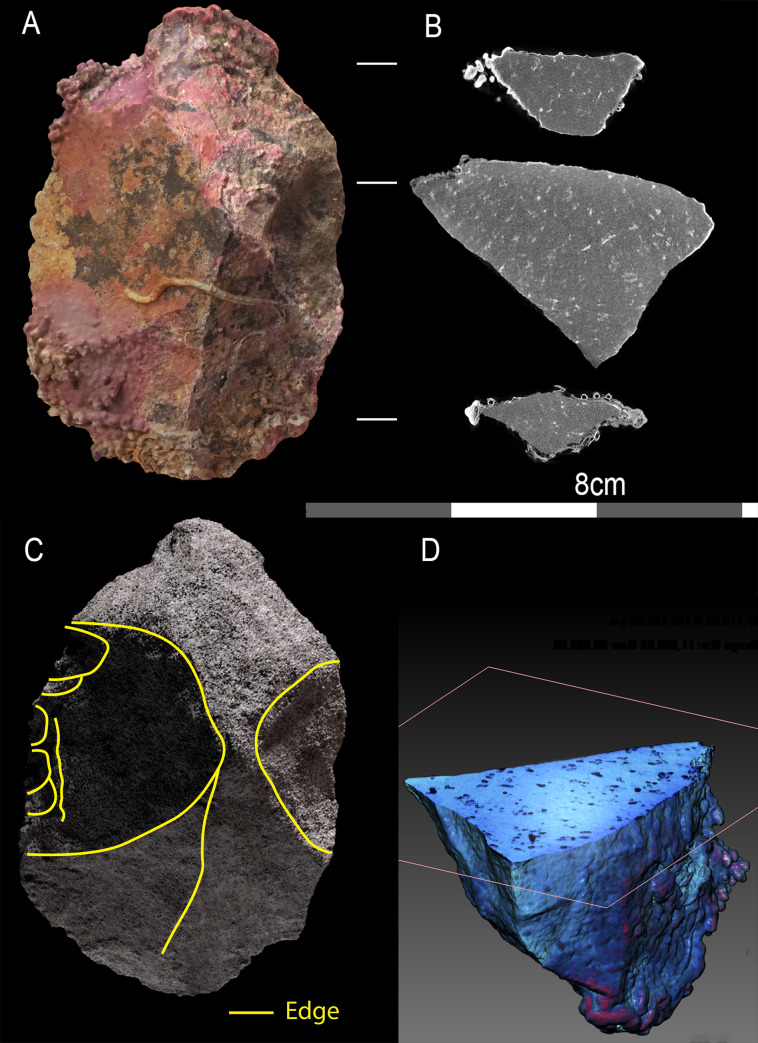
Views of subtidal lithic A23, showing photogrammetric view (A), neutron tomographic slice (B), digitally de-concreted 3D tomography (C) and digitally half-sectioned 3D tomography.